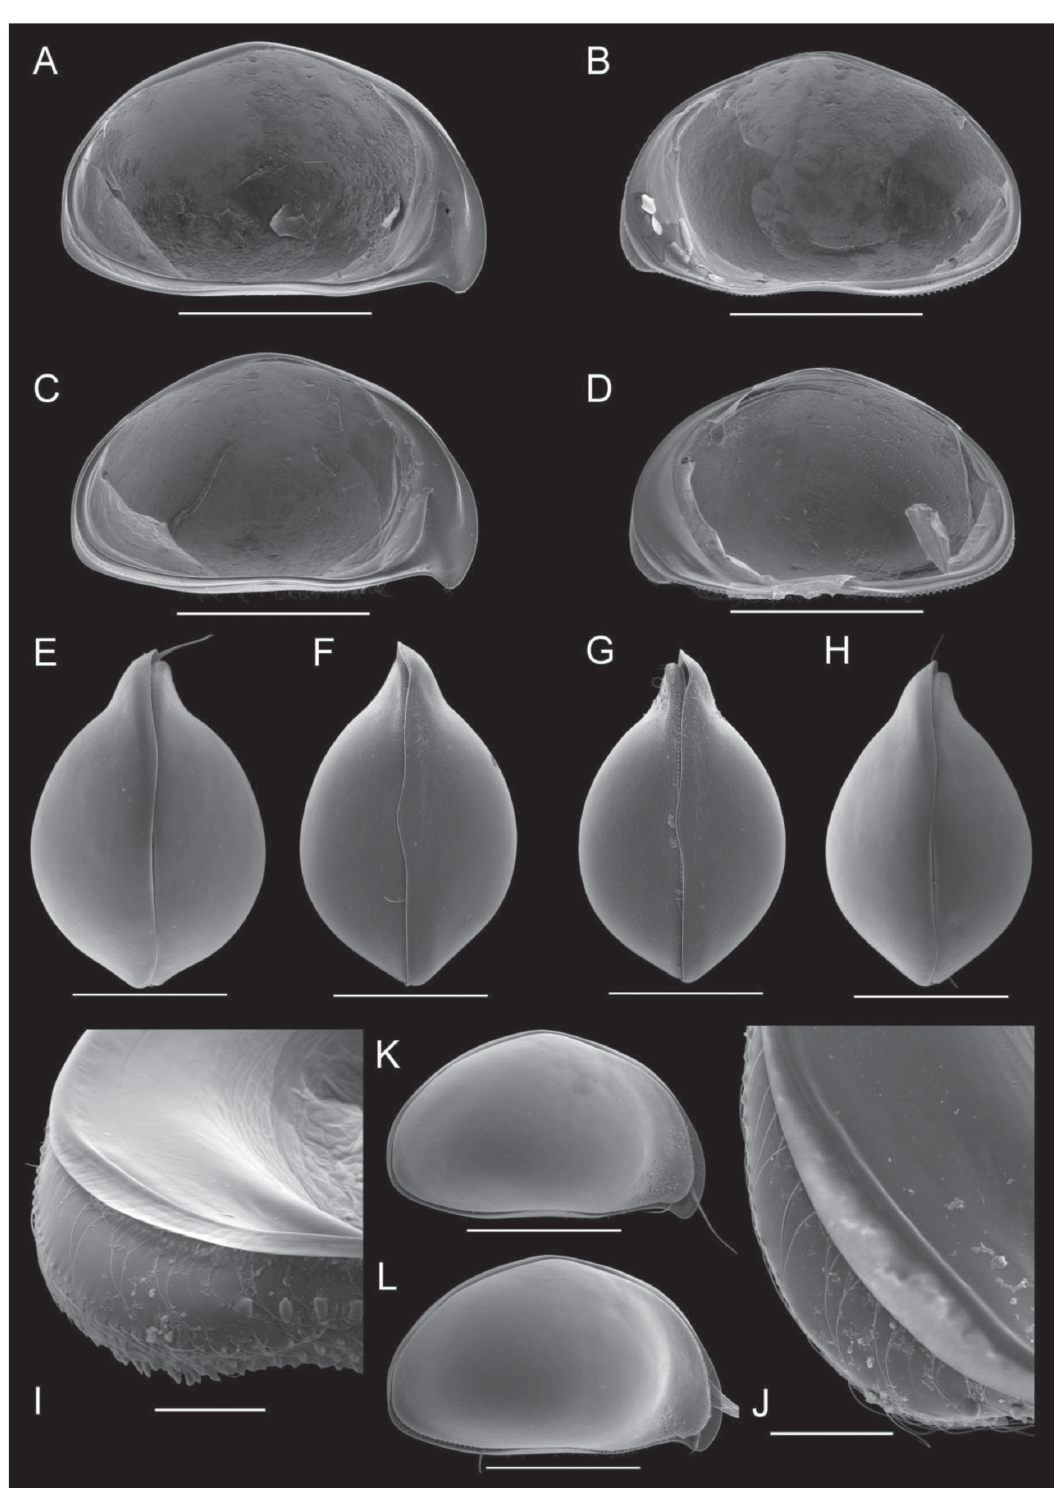
Fig. 9. Bennelongia pinpi De Deckker, 1981, all from Salt Lake, north of Hughenden, QLD. A . ♀, LVi (W40028). B . ♀, RVi (W40028). C . ♂, LVi (W40027). D . ♂, RVi (W40027). E . ♀, Cp dorsal (W40030). F . ♀, Cp ventral (W40031). G . ♂, Cp ventral (W40032). H . ♂, Cp dorsal (W40034). I . ♂, RVi detail anteriorly (W40027). J . ♂, RVi detail anteriorly (W40027). K . ♂, CpRl (W40033). L . ♀, CpRl (W40029). Scales: A-H, K-L = 1000 μm, J-I = 100